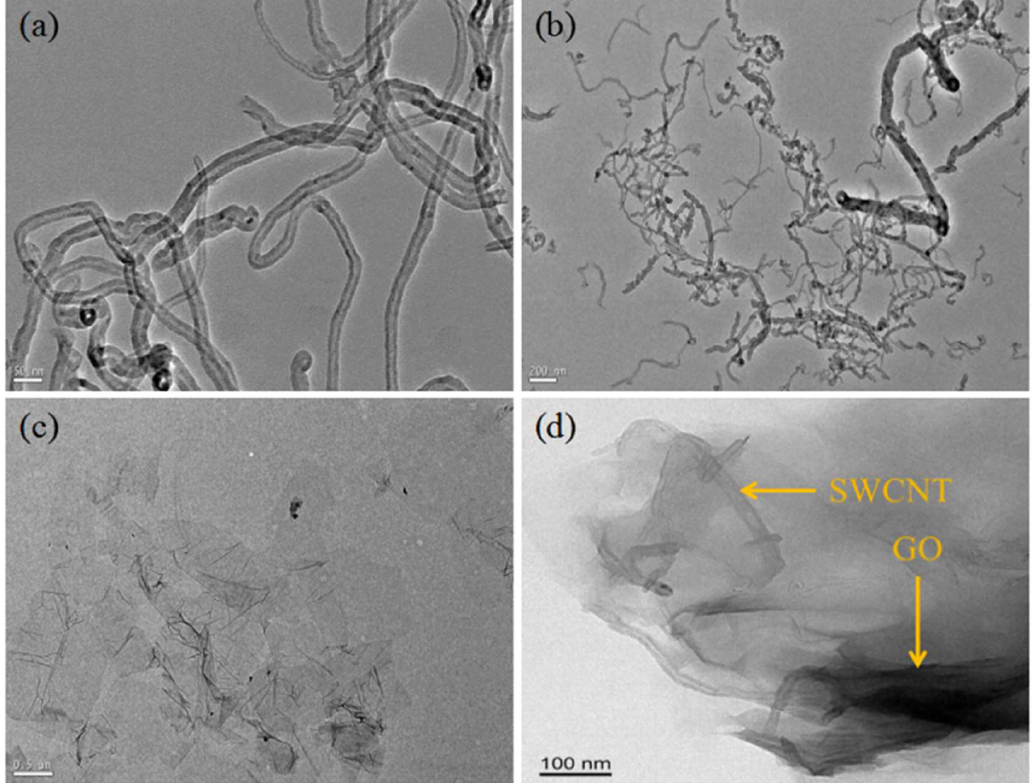
Figure 4. The TEM images of ( a ) original SWCNTs, ( b ) purify SWCNTs, ( c ) GO, ( d )